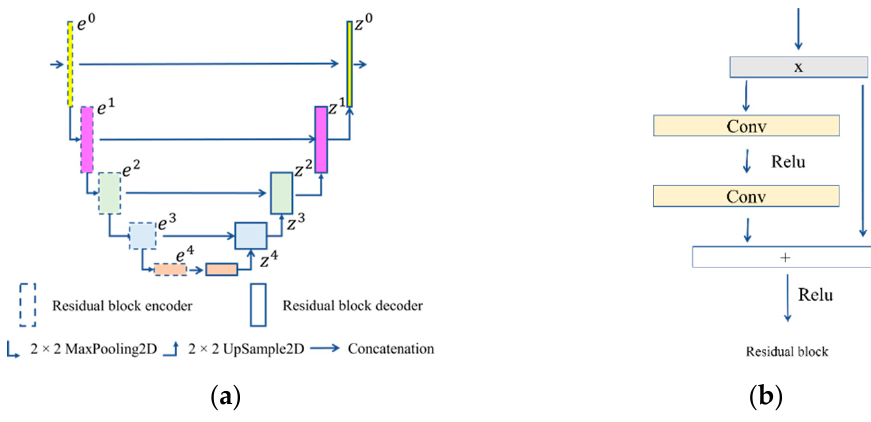
Figure 2. Residual U-Net structure. ( a ) U-Net structure and ( b ) residual block.